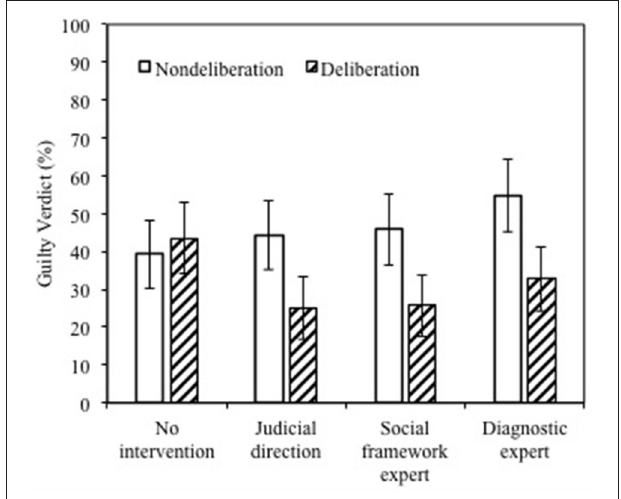
FIGURE 2 | Guilty verdict (%) by decision type and source of educative